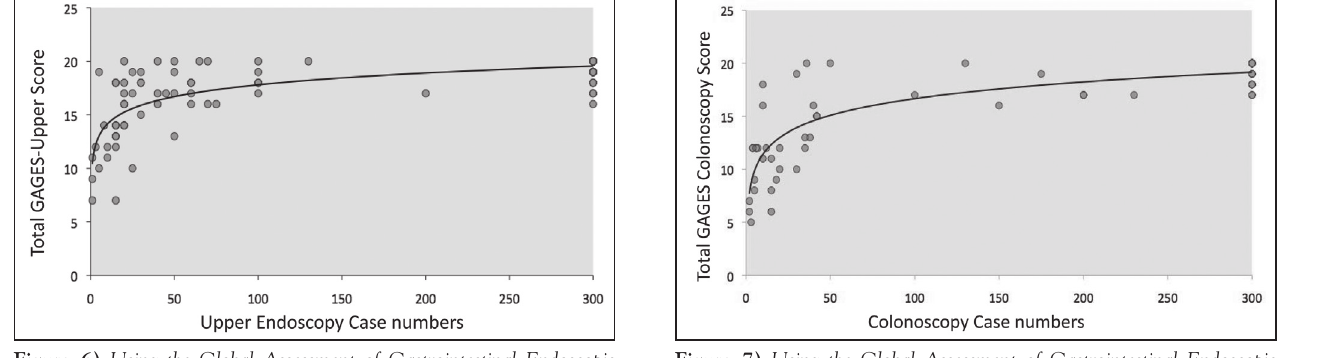
Figure 7) Using the Global Assessment of Gastrointestinal Endoscopic Skills (GAGES) to access proficiency at lower gastrointestinal